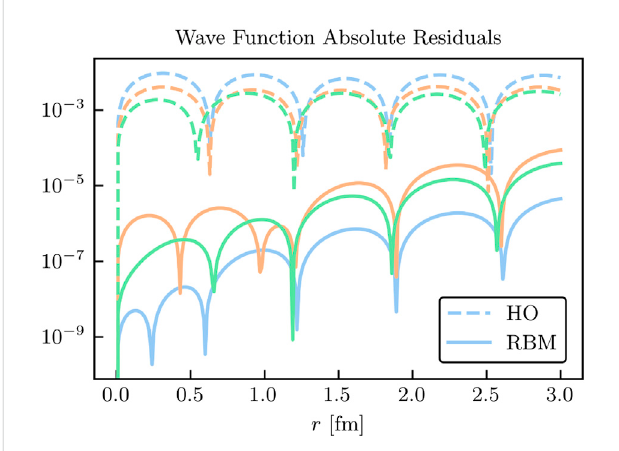
FIGURE 5 Absolute residuals of the emulated wave functions (in fm − 1/2 ) based on the RBM and HO emulator as a function of r , with colors corresponding to those in Figure 4. The emulator results are compared to the exact solutions. See the main text for